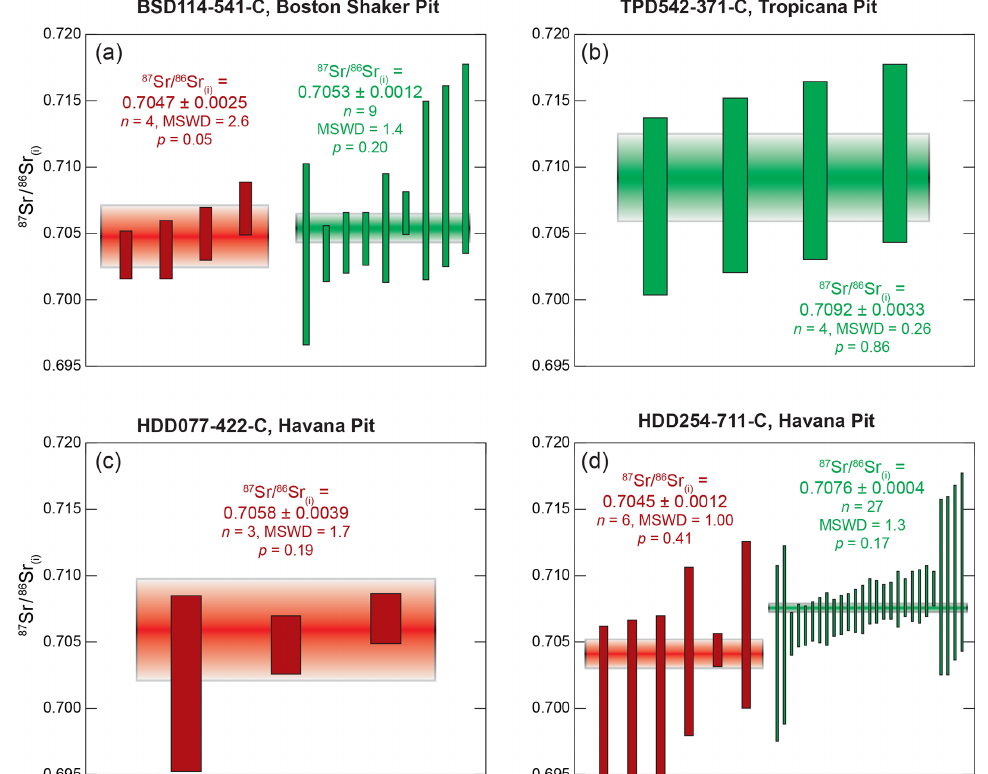
Figure 9. Apatite weighted mean 87 Sr / 86 Sr. Due to the lack of Rb in apatite, measured 87 Sr / 86 Sr values can be considered as initial ratios.